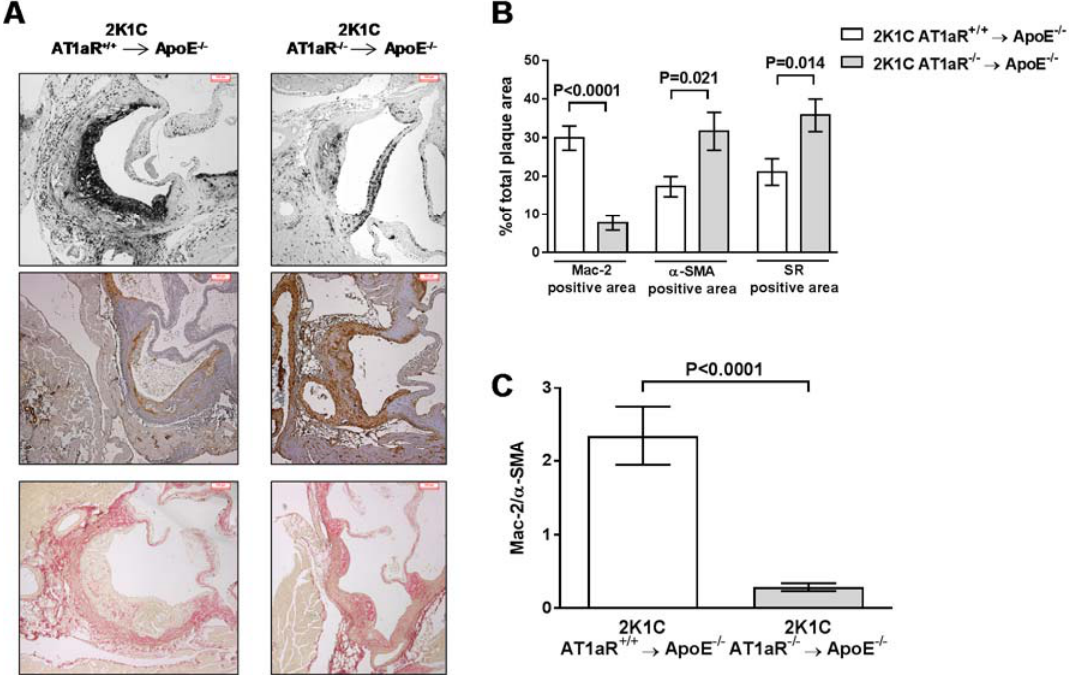
Figure 4. AT1aR deficiency in BM ‐ derived cells prevents Ang II ‐ mediated vulnerable plaques containing a high number of macrophages, and low content of SM cells and collagen. ( A ) Representative photographs of aortic sinus cross ‐ sections immunostained for Mac ‐ 2 (top panel) and α‐ SM actin (middle panel) for macrophage and SM cells determination, respectively, or stained with Sirius Red (bottom panel) for collagen determination in 2K1C ApoE − / − mice transplanted with either AT1aR +/+ or AT1aR − / − BM (scale bar = 100 μ m). ( B ) Quantification of Mac ‐ 2, α‐ SM actin, and Sirius Red positive staining over the total area of plaque. ( C ) Quantification of Mac ‐ 2 to α‐ SM actin ratio. Data are mean ± SEM. n = 12 to16 animals per group.